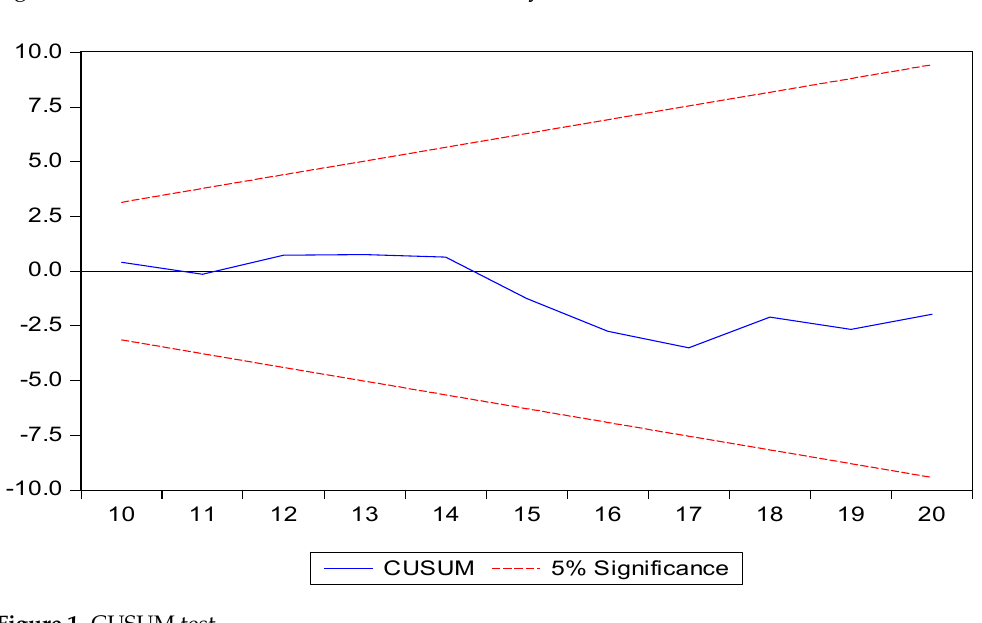
Figure 1. CUSUM test.